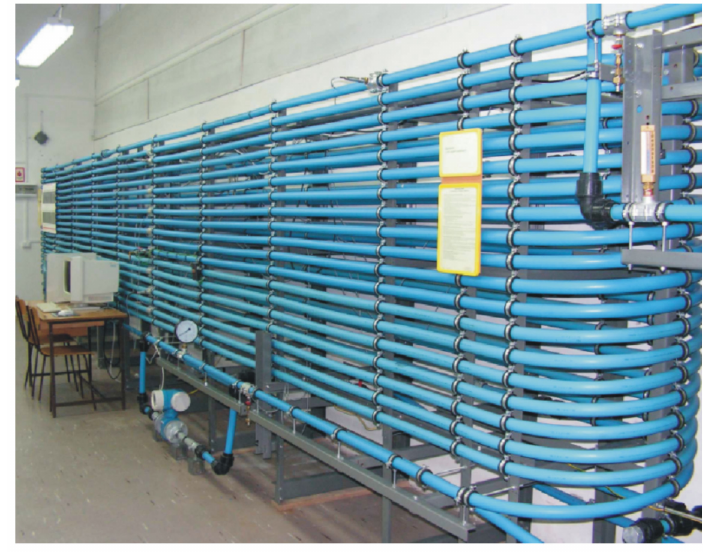
Figure 2. Laboratory model of the pipeline used during experiments.